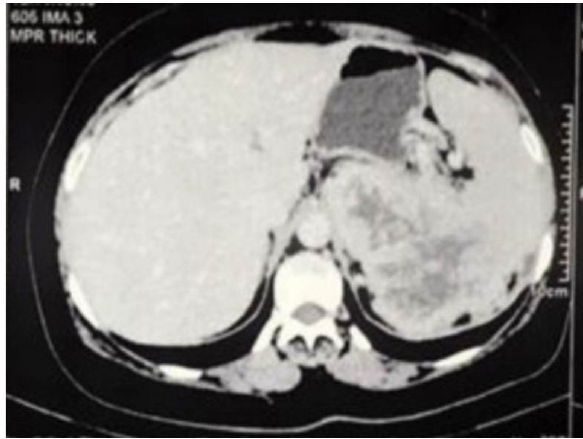
Figure 1: Axial CT abdomen showing large left renal mass infiltrating the spleen and pancreas.